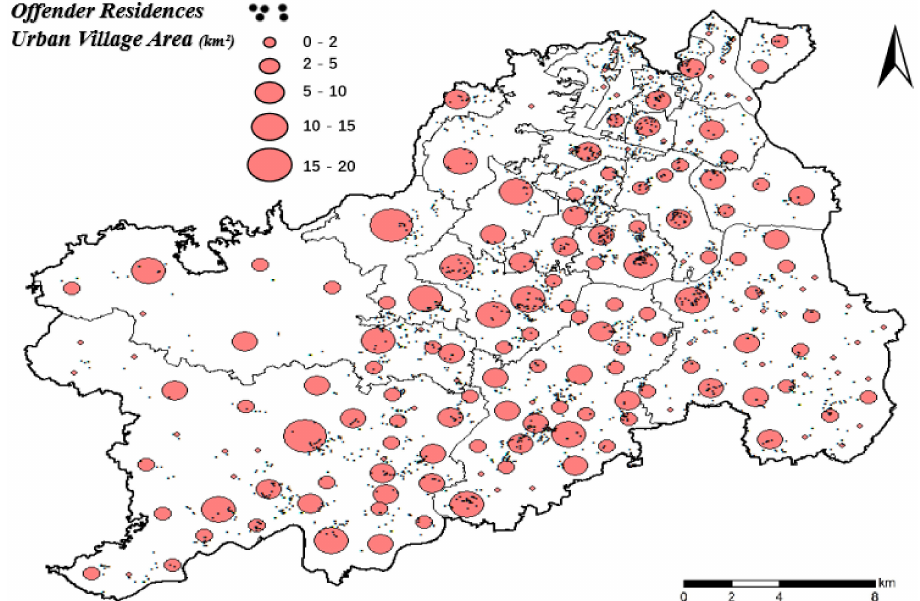
Figure 2. Location of offender residences and urban villages in the study area.